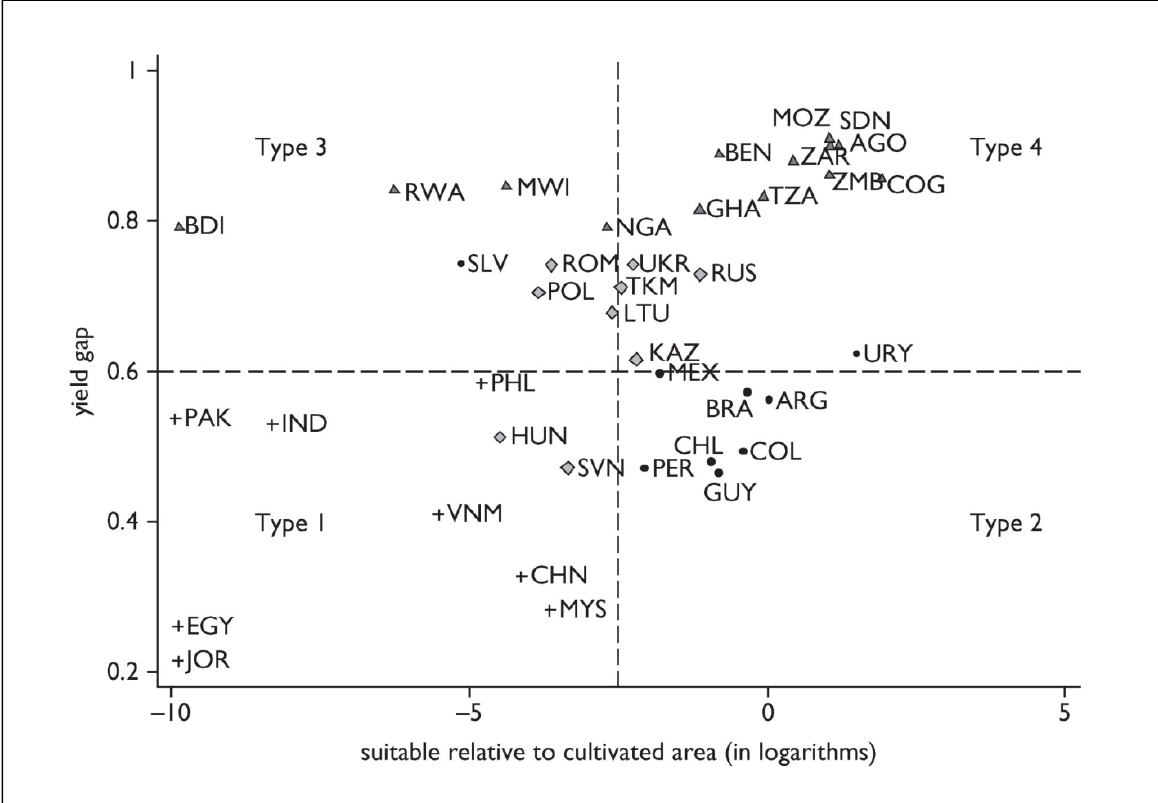
Note: Dashed lines indicate average yield gap and 50 th percentile for relative suitability. Source: Deininger, K., & Byerlee, D. (2011). Rising global interest in farmland: Can it yield sustainable and equitable benefits? [Based on Fisher & Shah, 2010]. Washington, D.C.: World Bank. Used with permission of The World